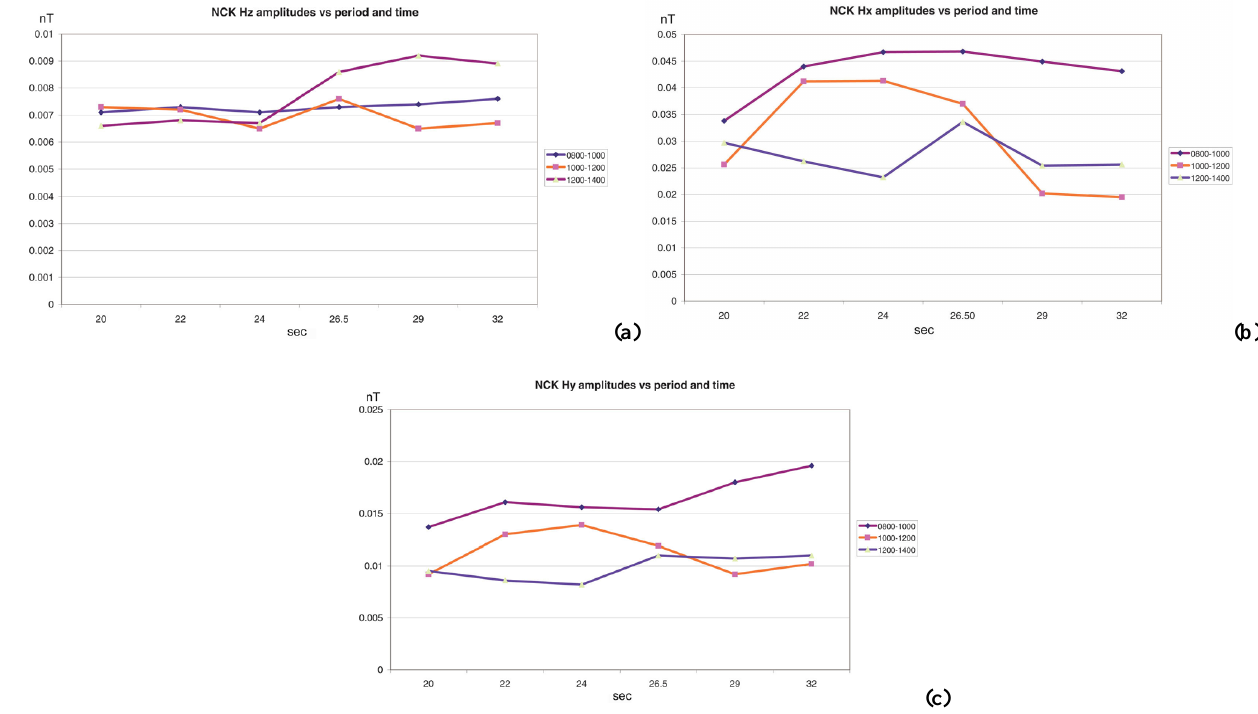
Fig. 6c. The same as Fig. 6a, but for the H y horizontal component. Fig. 6. (a) Pseudo-spectrum of the NCK vertical magnetic component ( H z ) in 2-h sections of time, for periods 20–32s. (For explanation of the pseudo-spectra, also see the text). (b) The same as Fig. 6a, but for the H x horizontal component. (c) The same as Fig. 6a, but for the H y horizontal component.